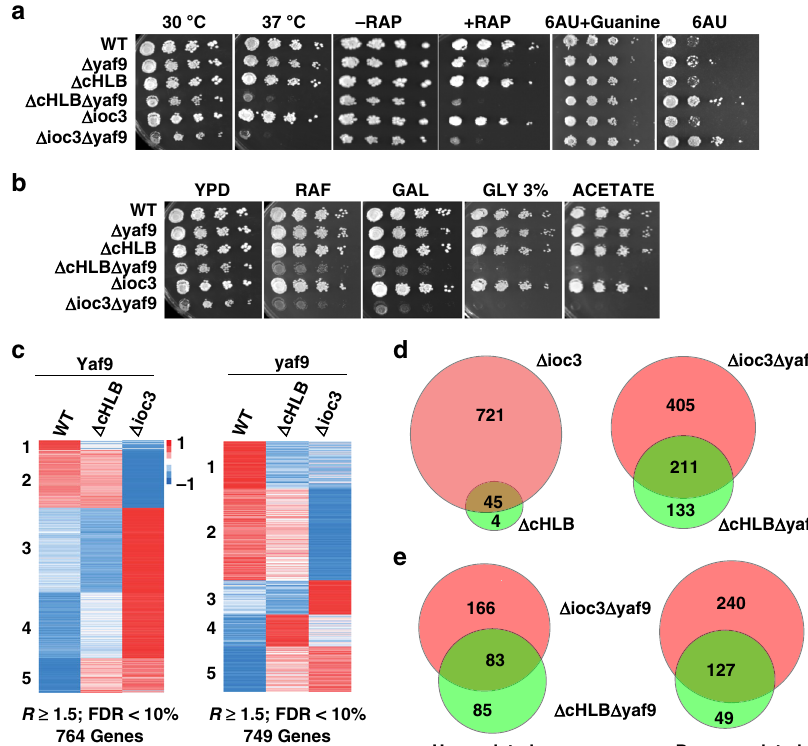
Fig. 8 The HLB domain of Ioc3 is required for ISW1a to regulate transcription in conjunction with NuA4/SWR1. a , b Shown are the changes in cell growth when subjected to a heat, Rapamycin (TOR signaling pathway) or 6-azauracil (6 AU) stress or b forced to use alternate carbon sources when IOC3 is mutated or deleted and YAF9 is deleted. Plates with 6 AU lack uracil and strains contained a centromeric plasmid (PRS416) with URA + marker. The assay had a minimum of three biologically independent samples with results the same as those depicted. c The heat map shows gene expression levels for wild-type (WT), ioc3 Δ cHLB and ioc3 Δ in YAF9 or yaf9 Δ background strains. Genes with over 1.5-fold change (FC) and false discovery rates (FDR) of <10% compared to wild type were identi fi ed and their Z scores plotted for wild-type and mutant ISW1a. The up (red) and down (blue) regulated genes are shown. Data are from three biologically independent samples. d A Venn diagram is shown for the overlap of genes differentially regulated in ioc3 Δ versus cHLB Δ and ioc3 Δ yaf9 Δ versus ioc3 Δ cHLByaf9 Δ with hypergeometric p value for the overlap being too small to be determined. In the lower half is shown the Venn diagram of the overlap of upregulated and downregulated genes for ioc3 Δ yaf9 Δ versus ioc3 Δ cHLByaf9 Δ with hypergeometric p value <3.78 e −